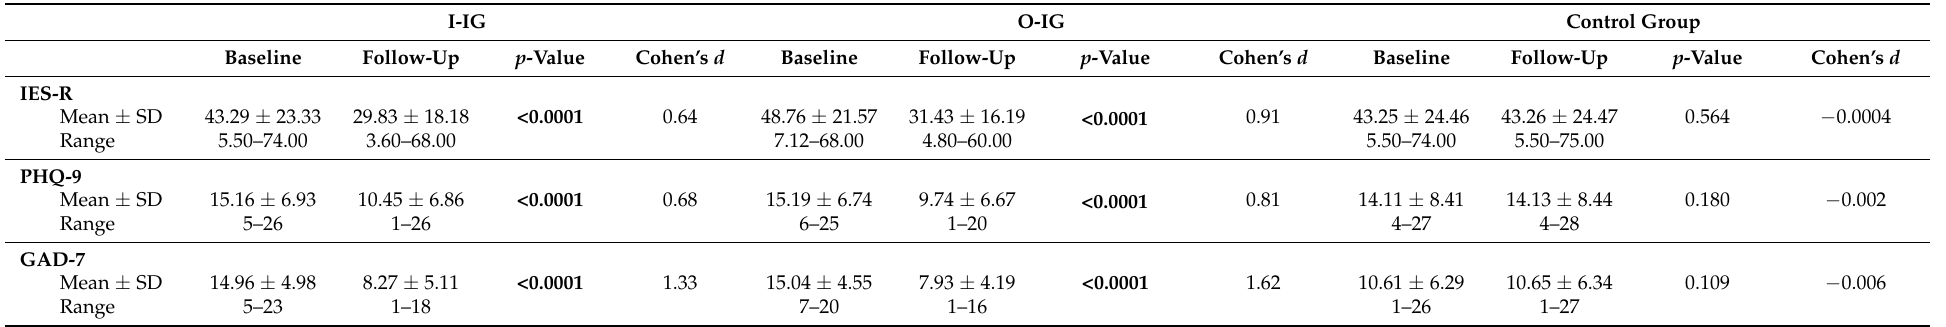
Table 2. PTSD risk, depression and anxiety assessment of internet-based intervention group (I-IG), onsite intervention group (O-IG) and control group at baseline and after a 6-month follow-up. I-IG O-IG Control